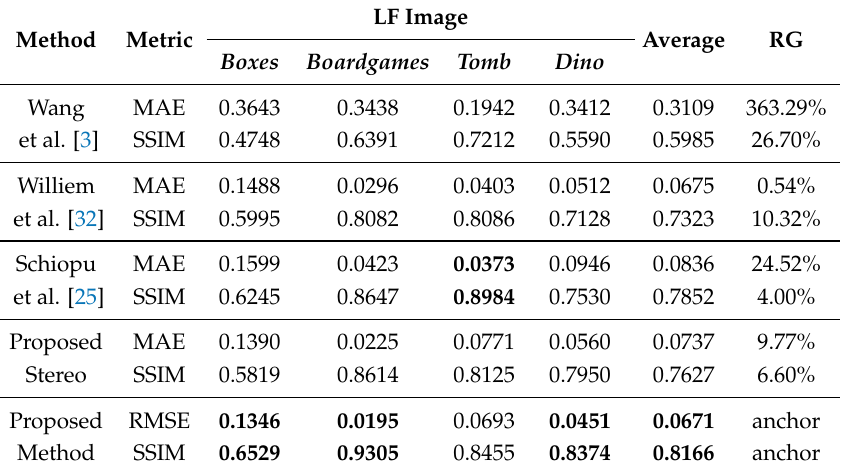
Table 2. Qualitative comparison in MAE and SSIM between computed and ground truth disparity maps for training configuration C2 of [25].